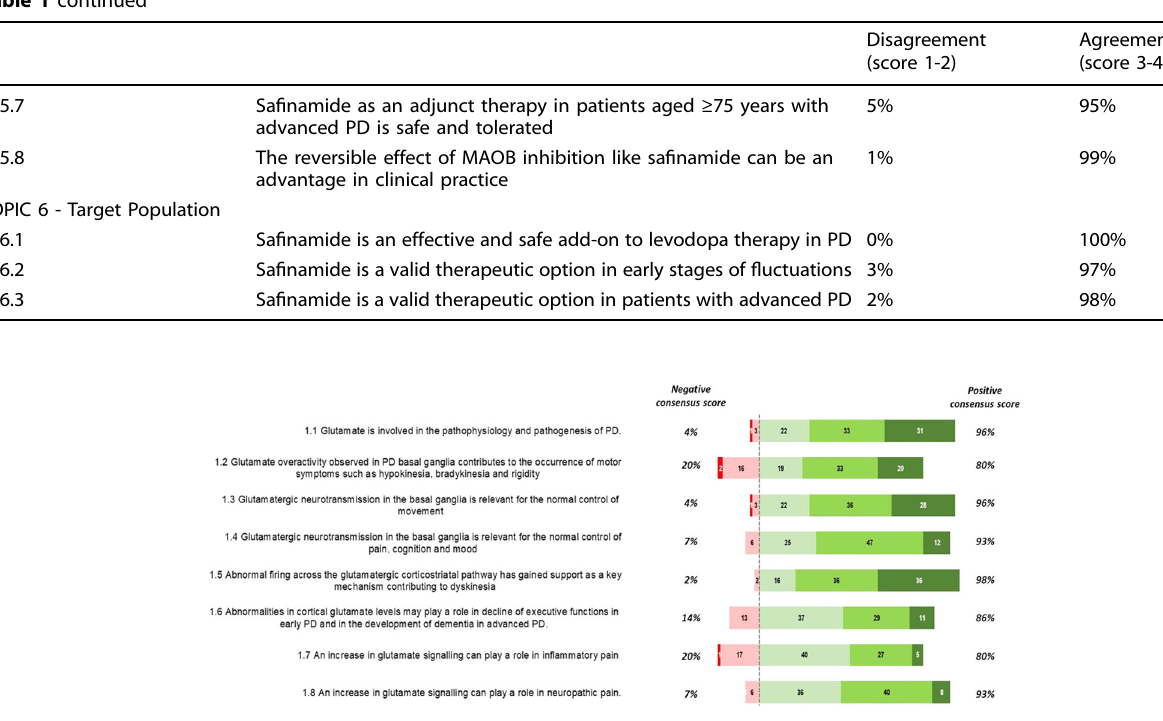
Fig. 1 Delphi questionnaire results: topic 1 “ Glutamate pathway role in Parkinson ’ s Disease ” . Numbers in the colored bars are the total number of votes received for each level of disagreement/agreement (1, extremely disagree; 2, disagree; 3, agree; 4, mostly agree; and 5, extremely agree). The “ negative consensus score ” and the “ positive consensus score3 are